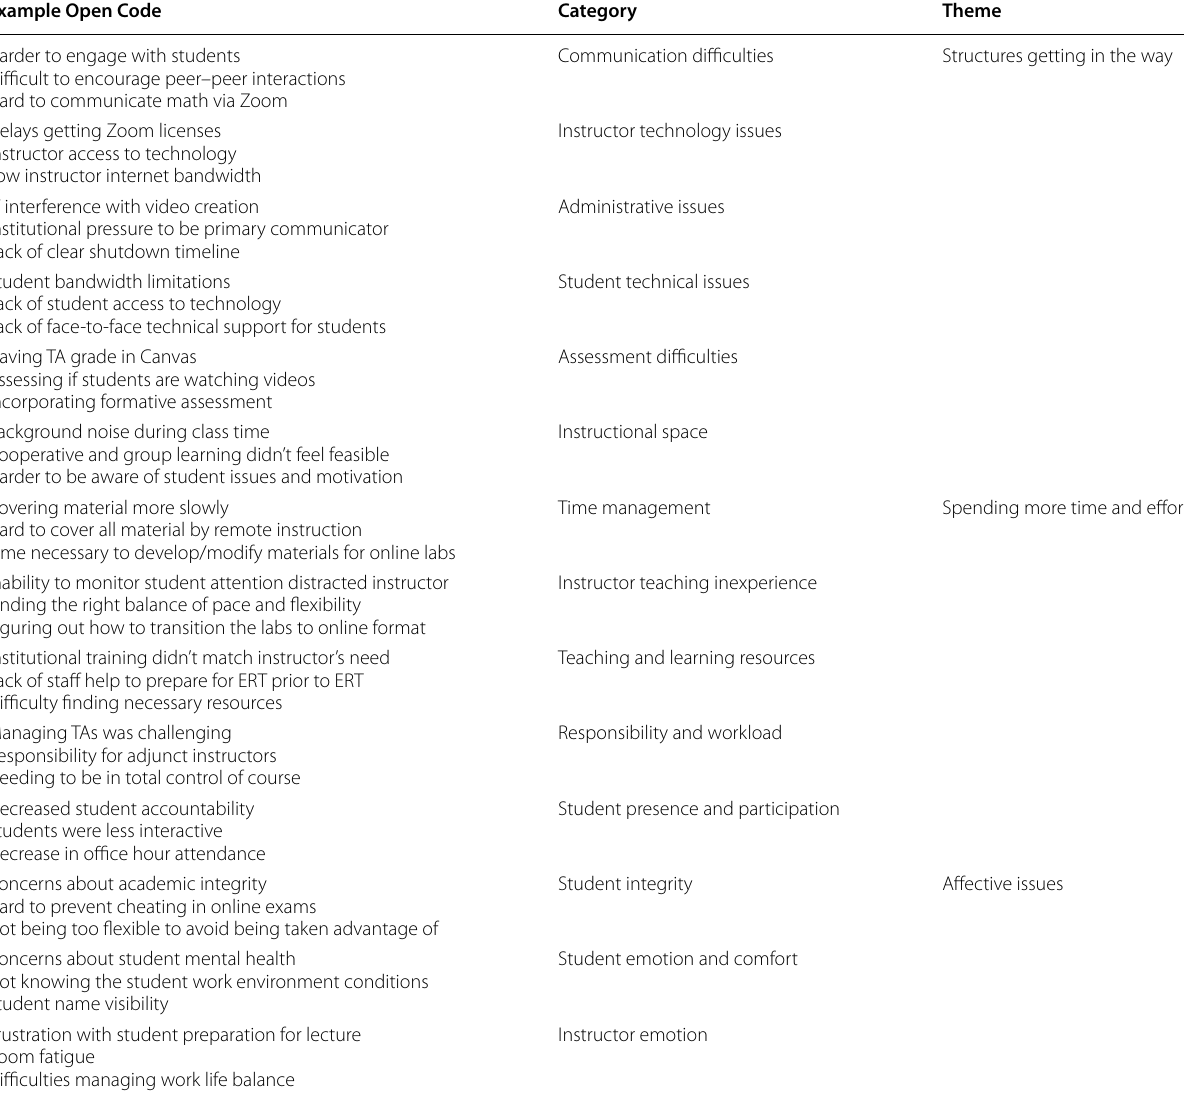
Table 10 Themes, categories, and sample codes for barriers Example Open